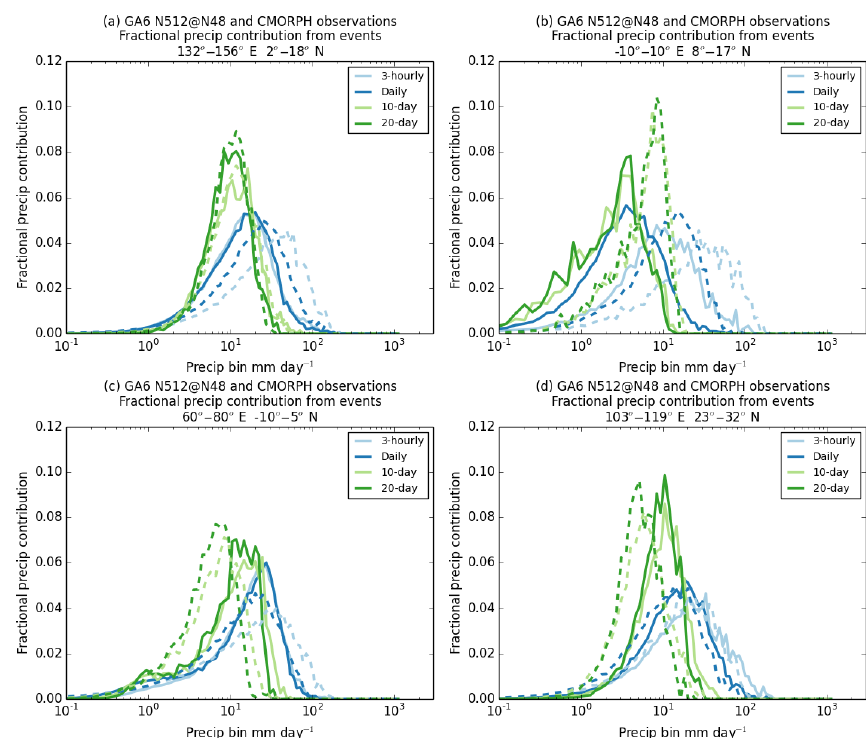
Figure 12. As Fig. 10 but for the MetUM-GA6 N512 configuration.